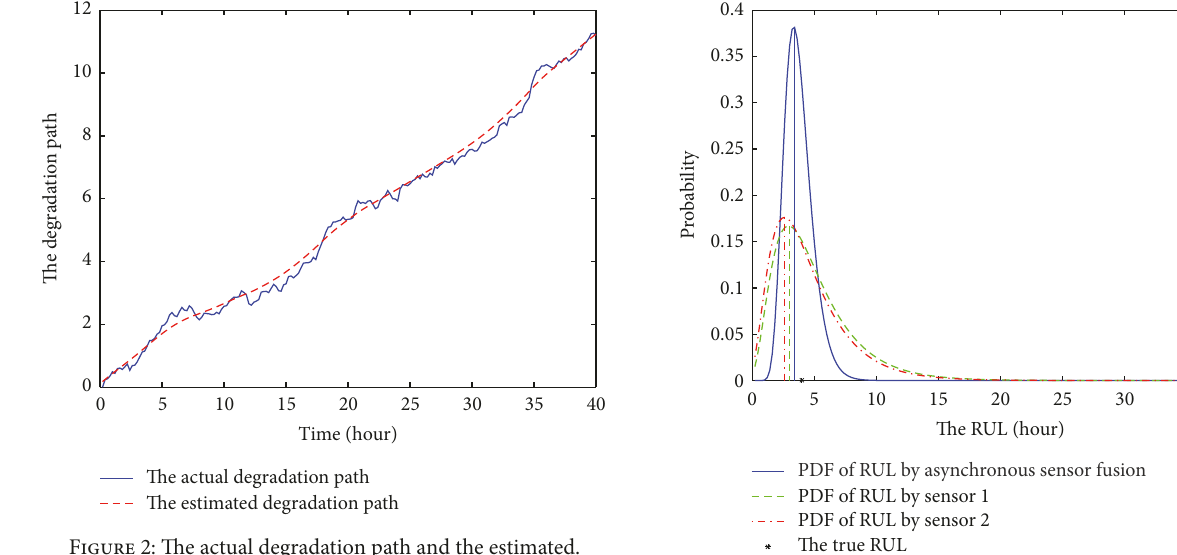
Figure 2: The actual degradation path and the estimated.